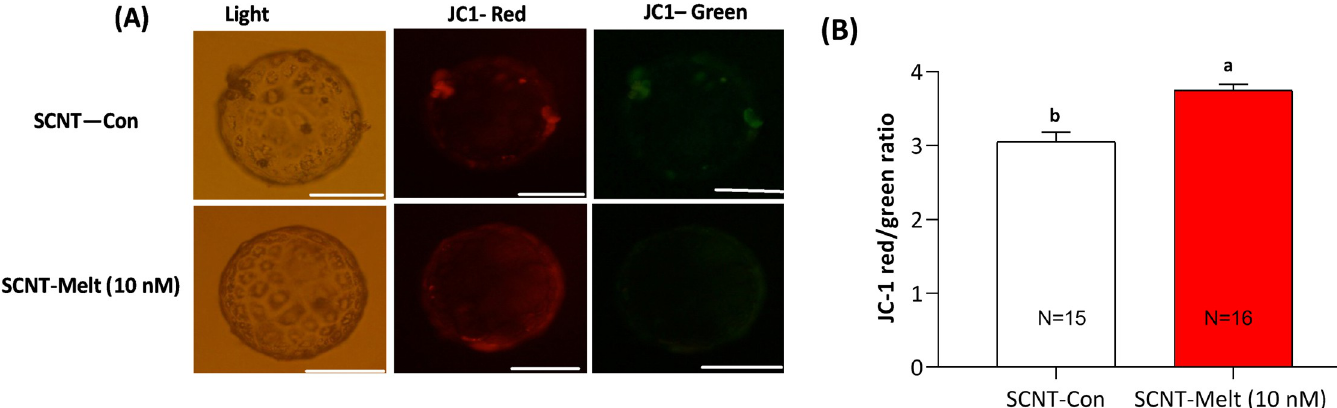
Fig 7. Effect of melatonin on the mitochondrial membrane potential ( Δ C m) in ovine SCNT blastocysts. (A) Relative fluorescent intensity of mitochondrial membrane potential in ovine SCNT blastocysts. Scale bar, 100 μ m (B) Quantity of mitochondrial membrane potential in ovine SCNT embryos treated with 10 nM melatonin or control group. The data were shown as mean ± SEM. Values with different letters have a statistically significant difference ( P < 0.05).